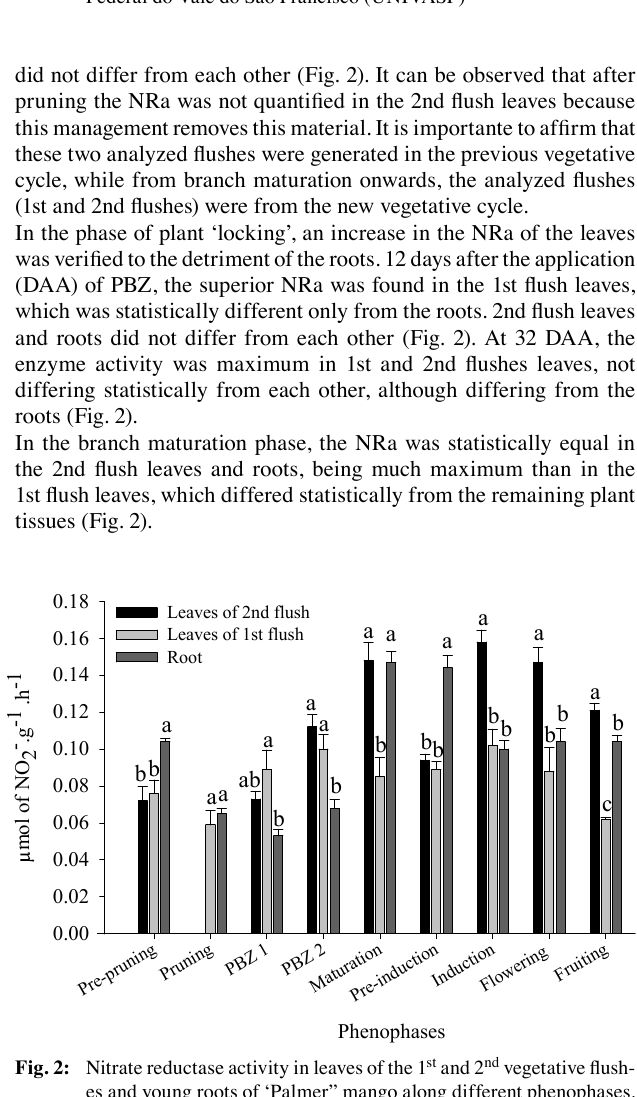
Fig. 1: Daytime variation of nitrate reductase activity in leaves of 1 st and 2 nd vegetative flushes and young roots of ‘Palmer’ mango and mean values of solar radiation obtained from the weather station at the Campus of Agricultural Sciences (CCA), of the Universidade